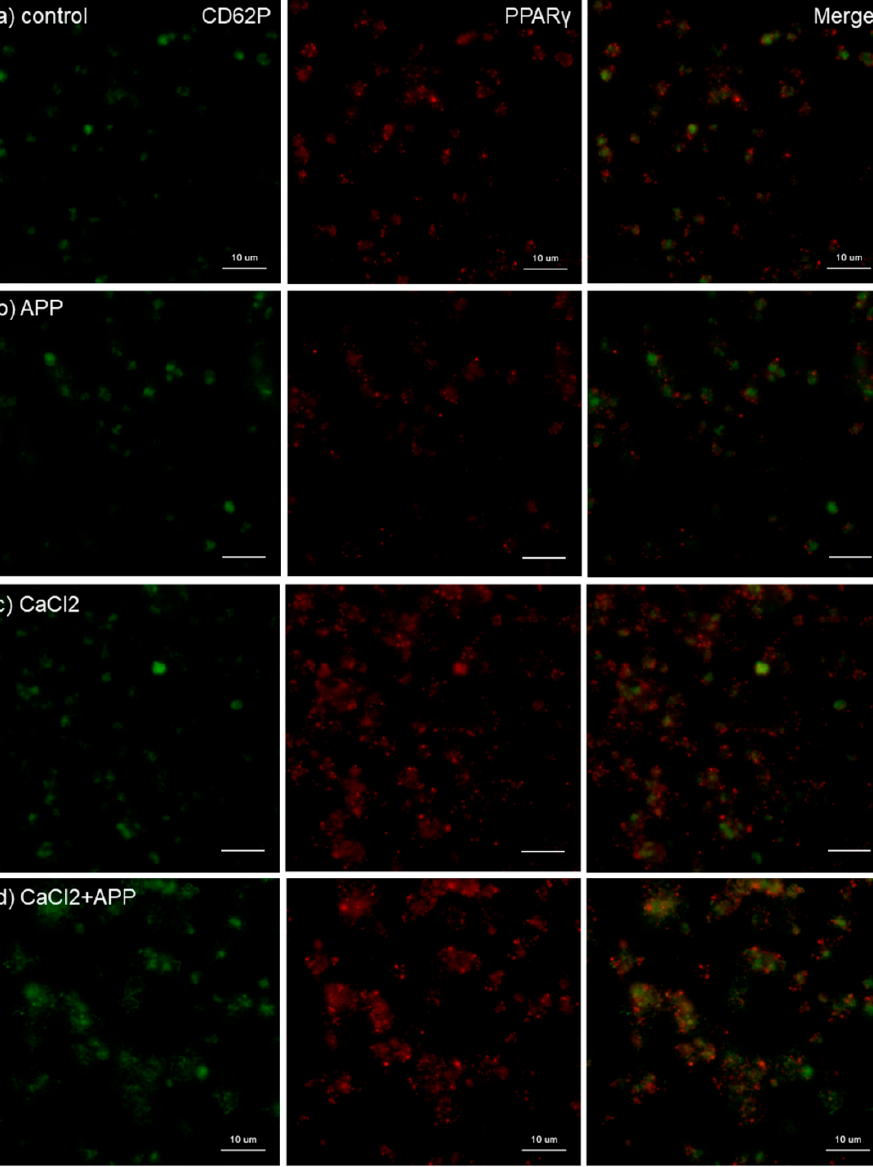
Figure 5. Effects of CaCl 2 and atmospheric pressure plasma (APP) treatments on PPAR γ distribution on cp -Ti plates at 30 min. Platelets were prepared, treated, and fixed for visualization (green: CD62P, red: PPAR γ ) as described in the legend of Figure 4. ( a ) Control platelets on non-treated cp -Ti plates, ( b ) control platelets on APP-treated cp -Ti plates, ( c ) CaCl 2 -stimulated platelets on non-treated cp -Ti plates, ( d ) CaCl 2 -stimulated platelets on APP-treated cp -Ti plates. Similar findings were obtained from the samples prepared from the other three donors. Bar = 10 μ m.